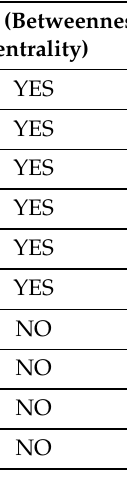
Table 7. Citation Analysis